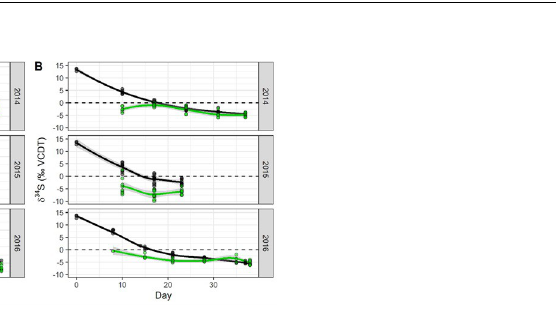
Fig 5. Results from diet-shift experiment, including previously published data from the 2016 experiment [71]. Each point represents a fish sampled over the duration of the study. The solid line is a loess smooth (span = 0.75) with a 95% confidence interval. Fish started with higher δ 13 C (A) and δ 34 S (B) values in their muscle tissue (black) because they were reared in a hatchery prior to the study. Over the course of the study, δ 13 C became lower but displayed ~ 1‰ fractionation, as expected as prey items are integrated into tissue. Whereas their muscle tissues δ 34 S values converged with the δ 34 S values from the stomach contents (green).